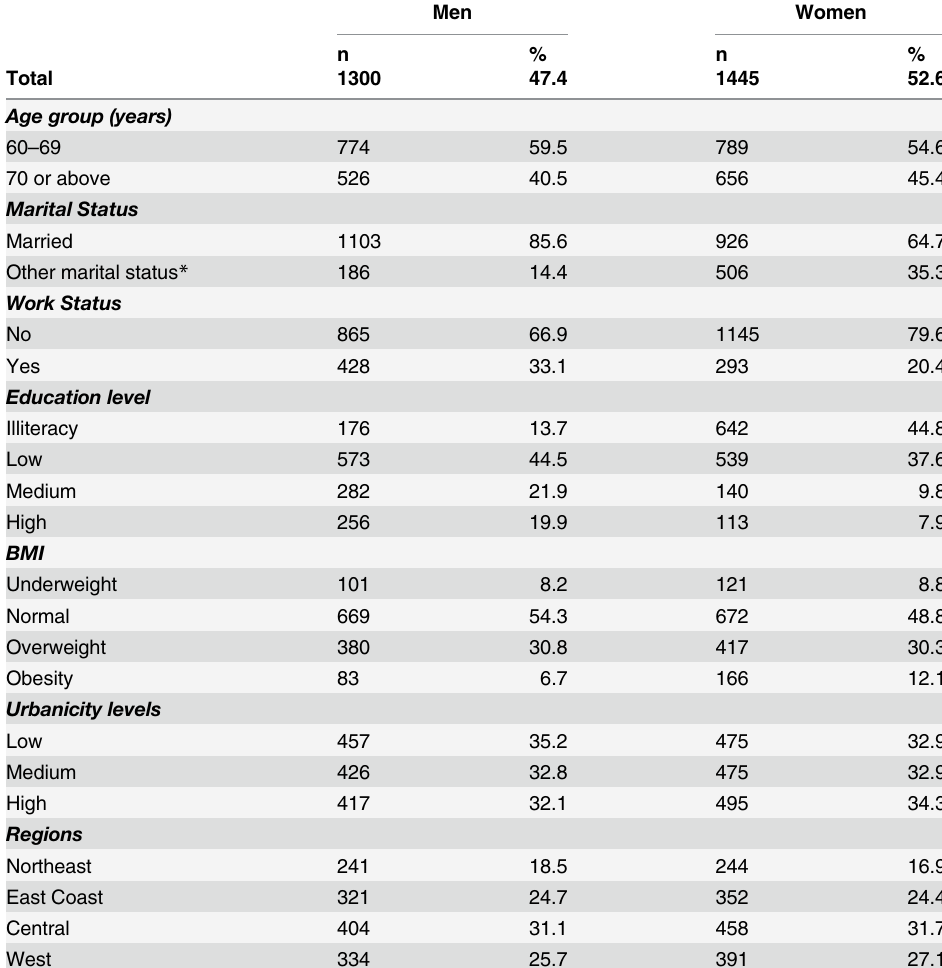
Table 1. Characteristics of study